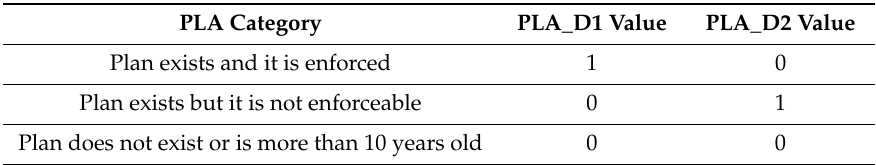
Table 2. Dummies for the planning variable